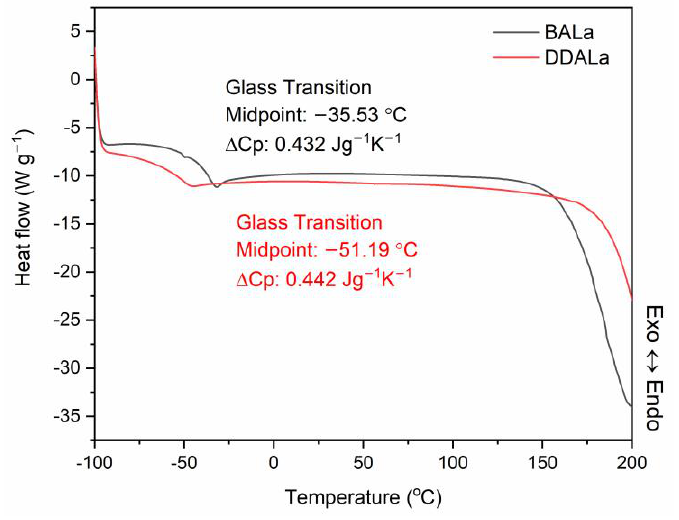
Figure 2. Differential scanning calorimetry (DSC) curves for pure DDALa and BALa.